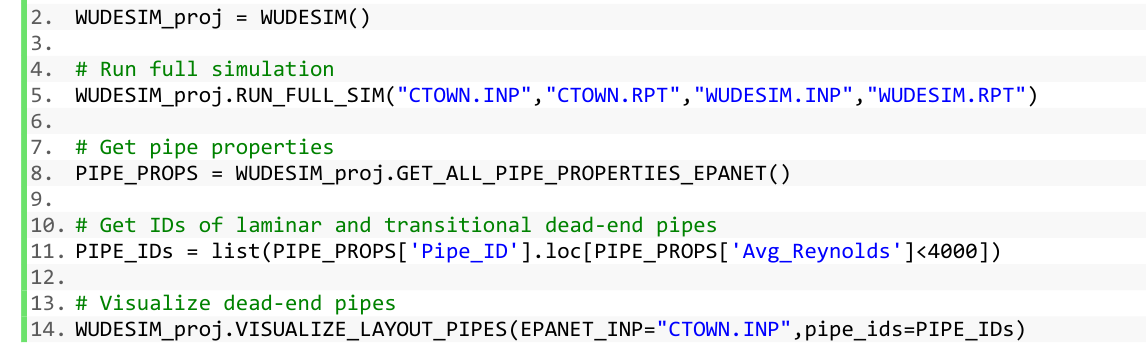
Figure 4. Example script for visualizing the layout of DEBs